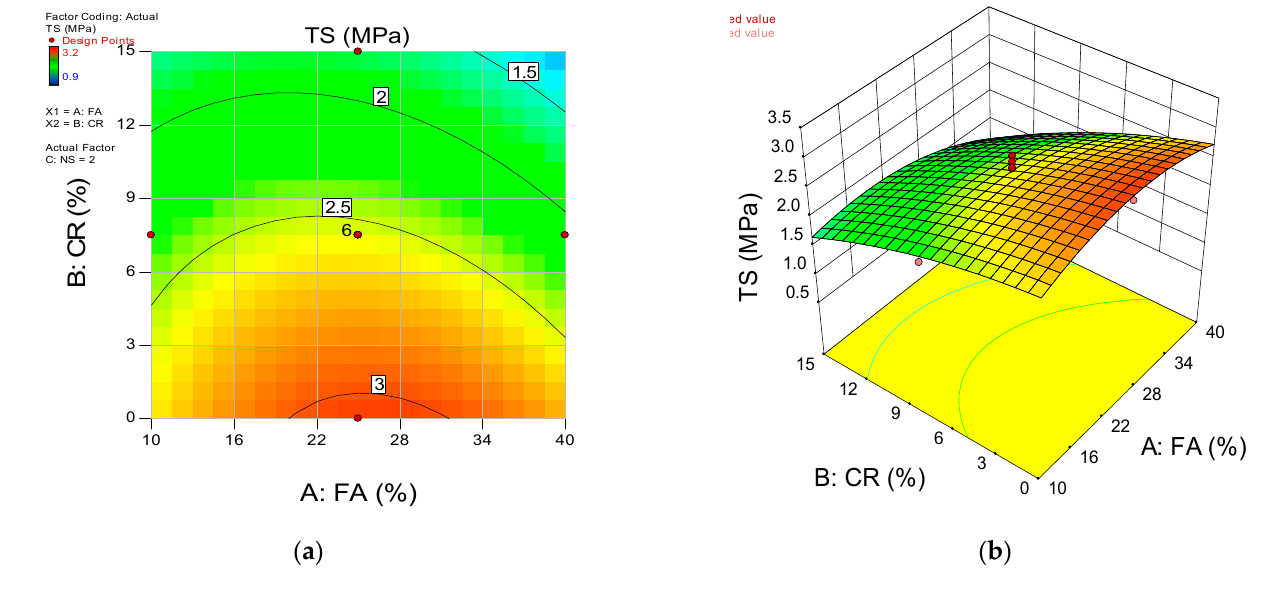
Table 6. Optimization goals and